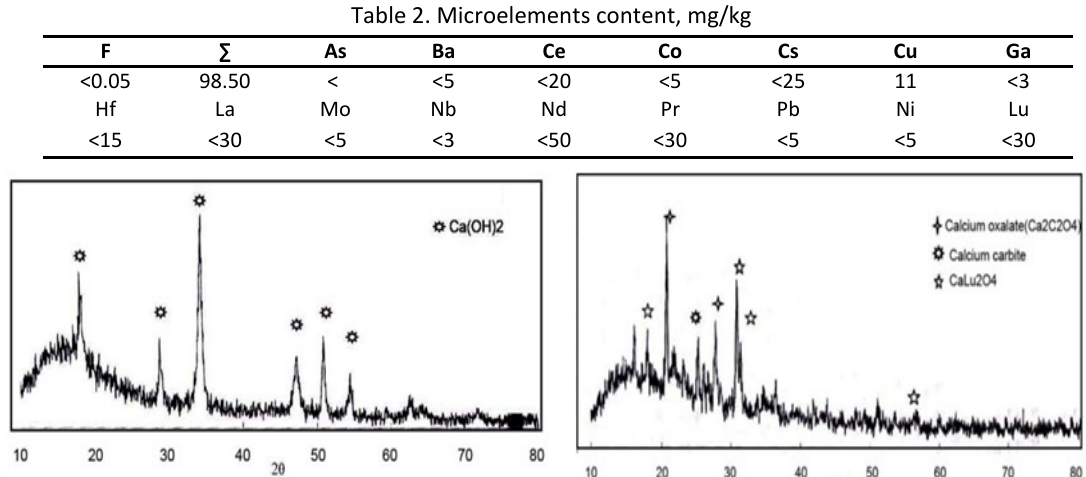
Table 2. Microelements content, mg/kg